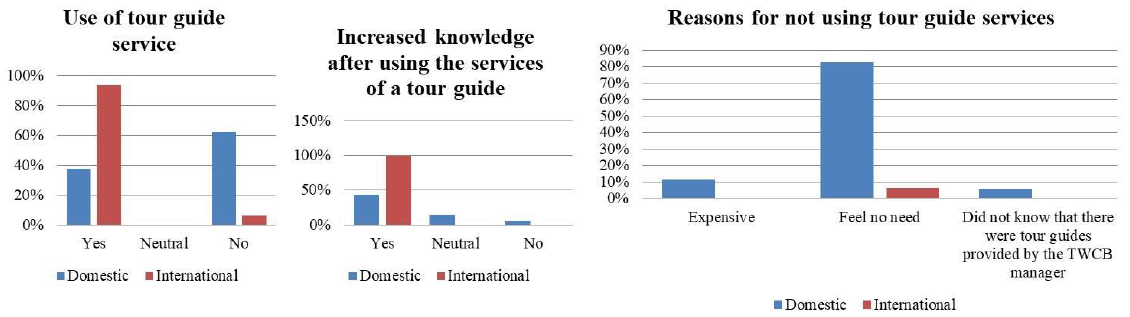
Fig. 7 Data related to the tour guide Source: